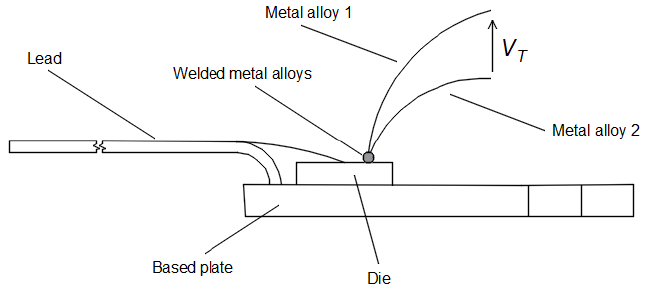
Figure 9. Die temperature measurement using a thermocouple based on a representative case of TO-220.